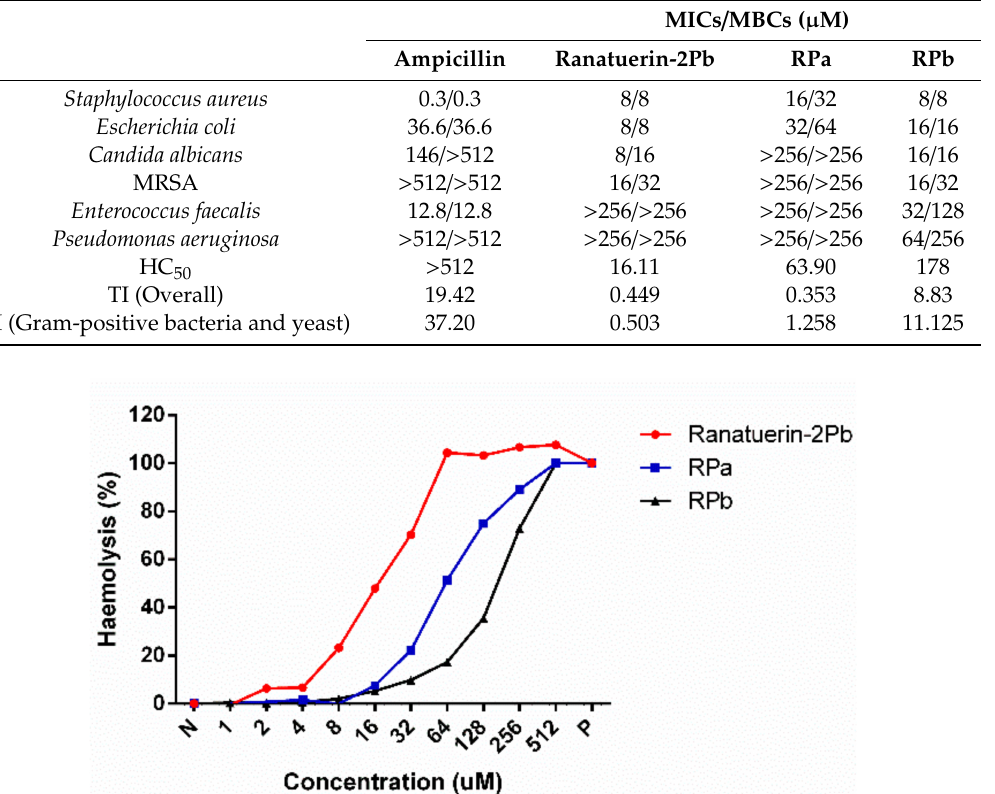
Table 3. Minimum inhibition concentrations (MICs) ( µ M) and minimum bactericidal concentrations (MBCs) ( µ M) of peptides against tested bacterias.